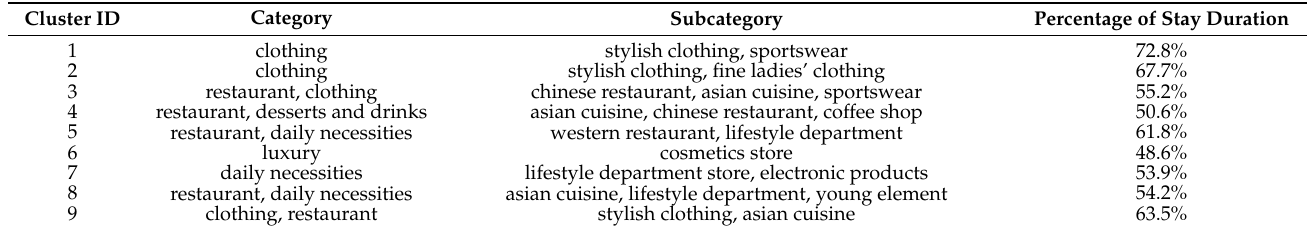
Table 13. Clustering results’